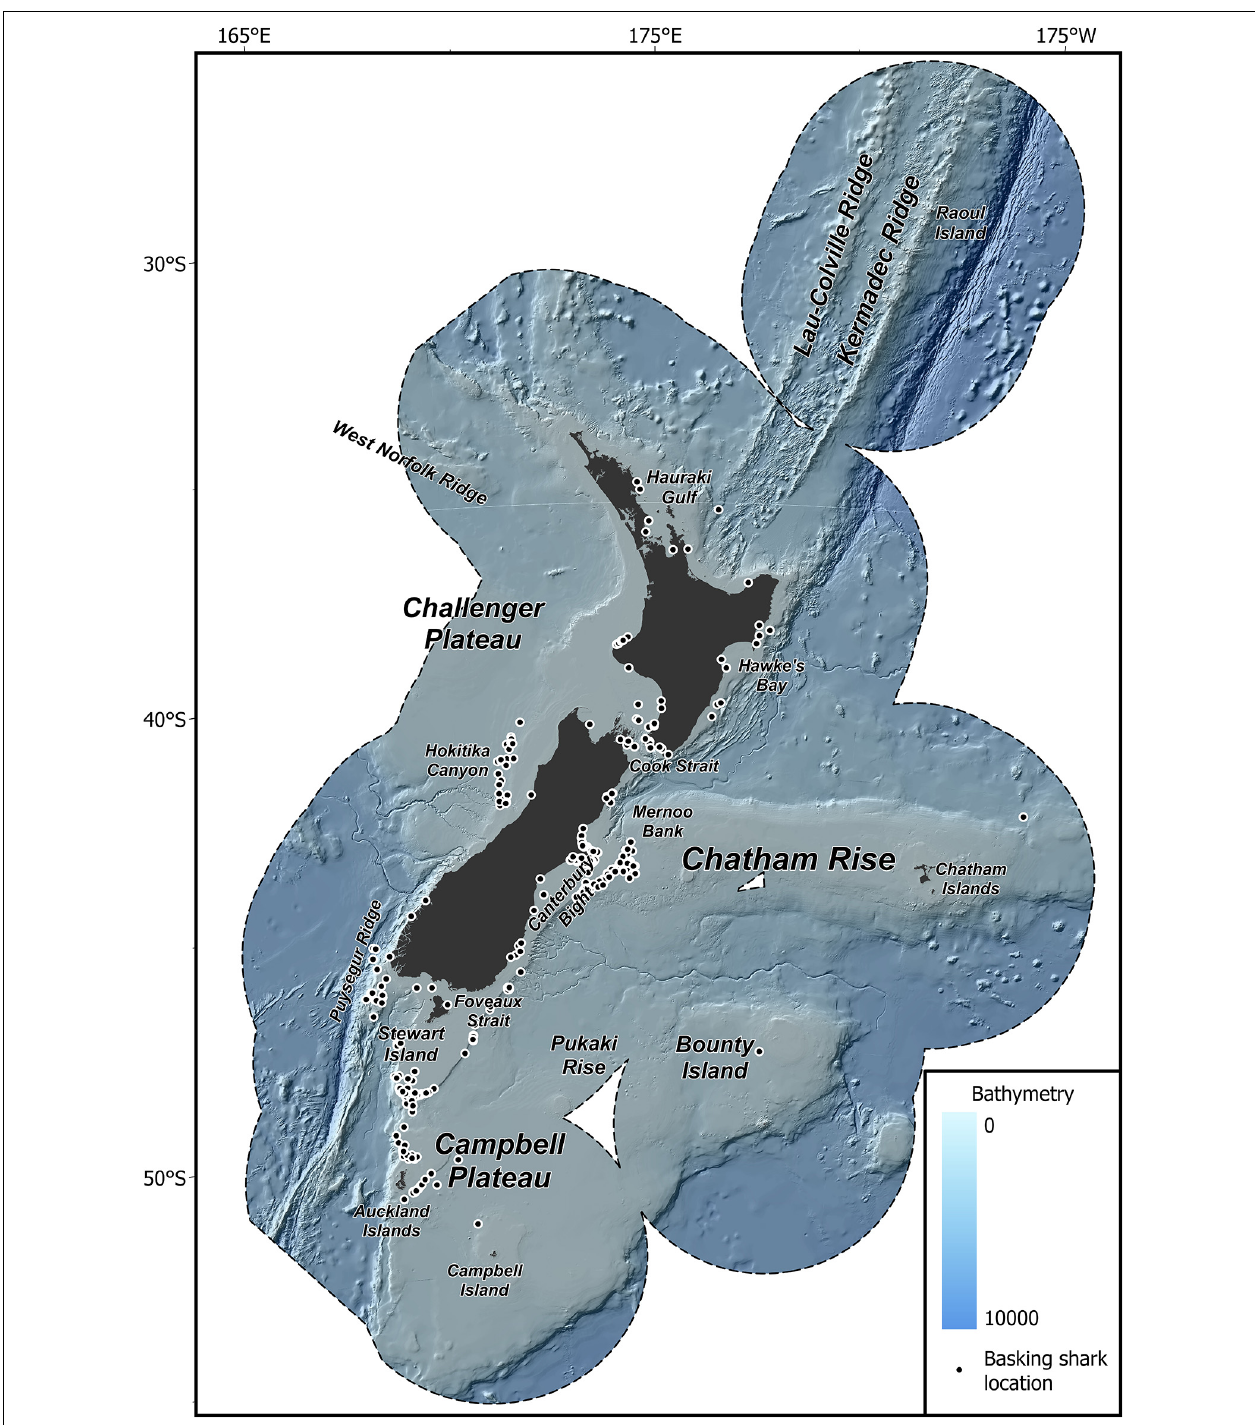
FIGURE 1 | Map of the study region. New Zealand Exclusive Economic Zone (EEZ, black dashed line), bathymetry, and feature names used throughout the text modified from Stephenson et al. (2020a), and the location of basking shark records used in this study (black dots).